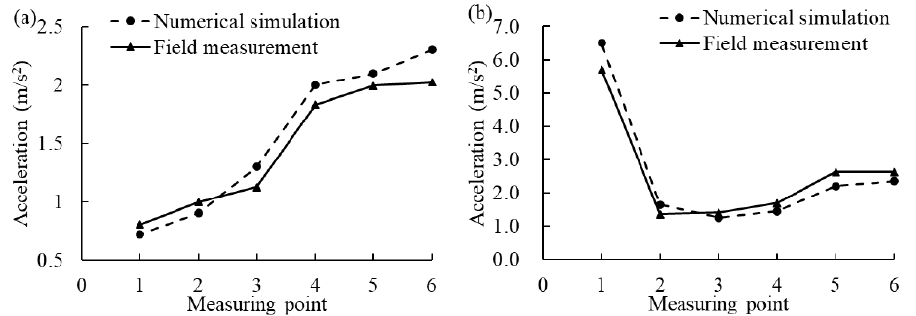
Figure 4. Comparison of vibration acceleration between numerical simulation and field measurement: ( a ) Transverse acceleration; ( b ) Vertical acceleration.